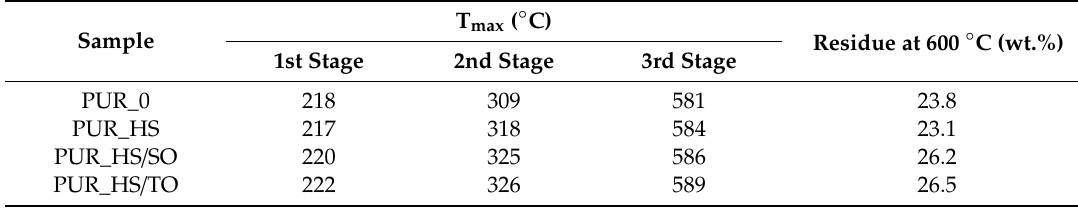
Table 5. The results of TGA and DTG analysis of PUR